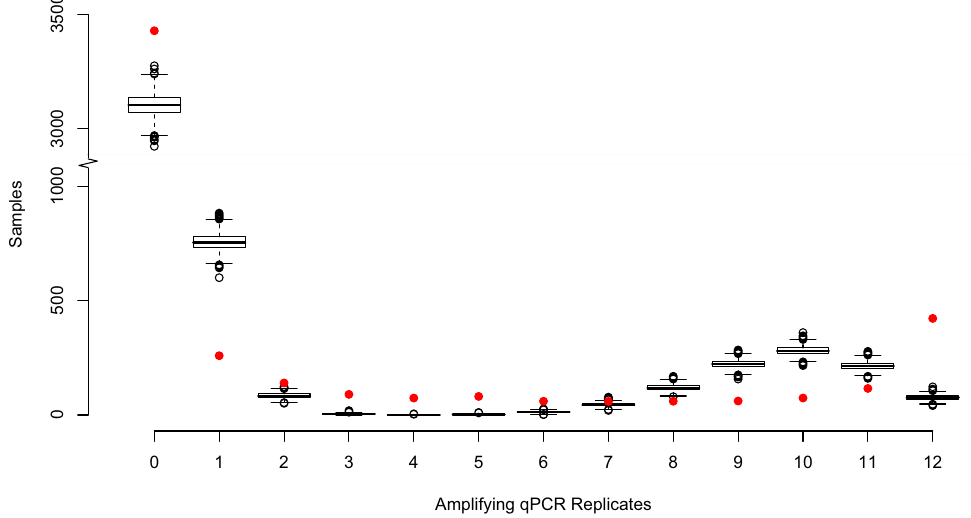
Figure 1. Frequency of qPCR replicate response within the observed data set (red dots), with boxplots representing the simulated median, IQR and whiskers at quartile + /− 1.5 IQR for the 100 repeats of simulated data, based on the modelled individual site occupancy and probabilities for both Stage 1 and Stage 2 true and false positives from the goodness of fit analysis.